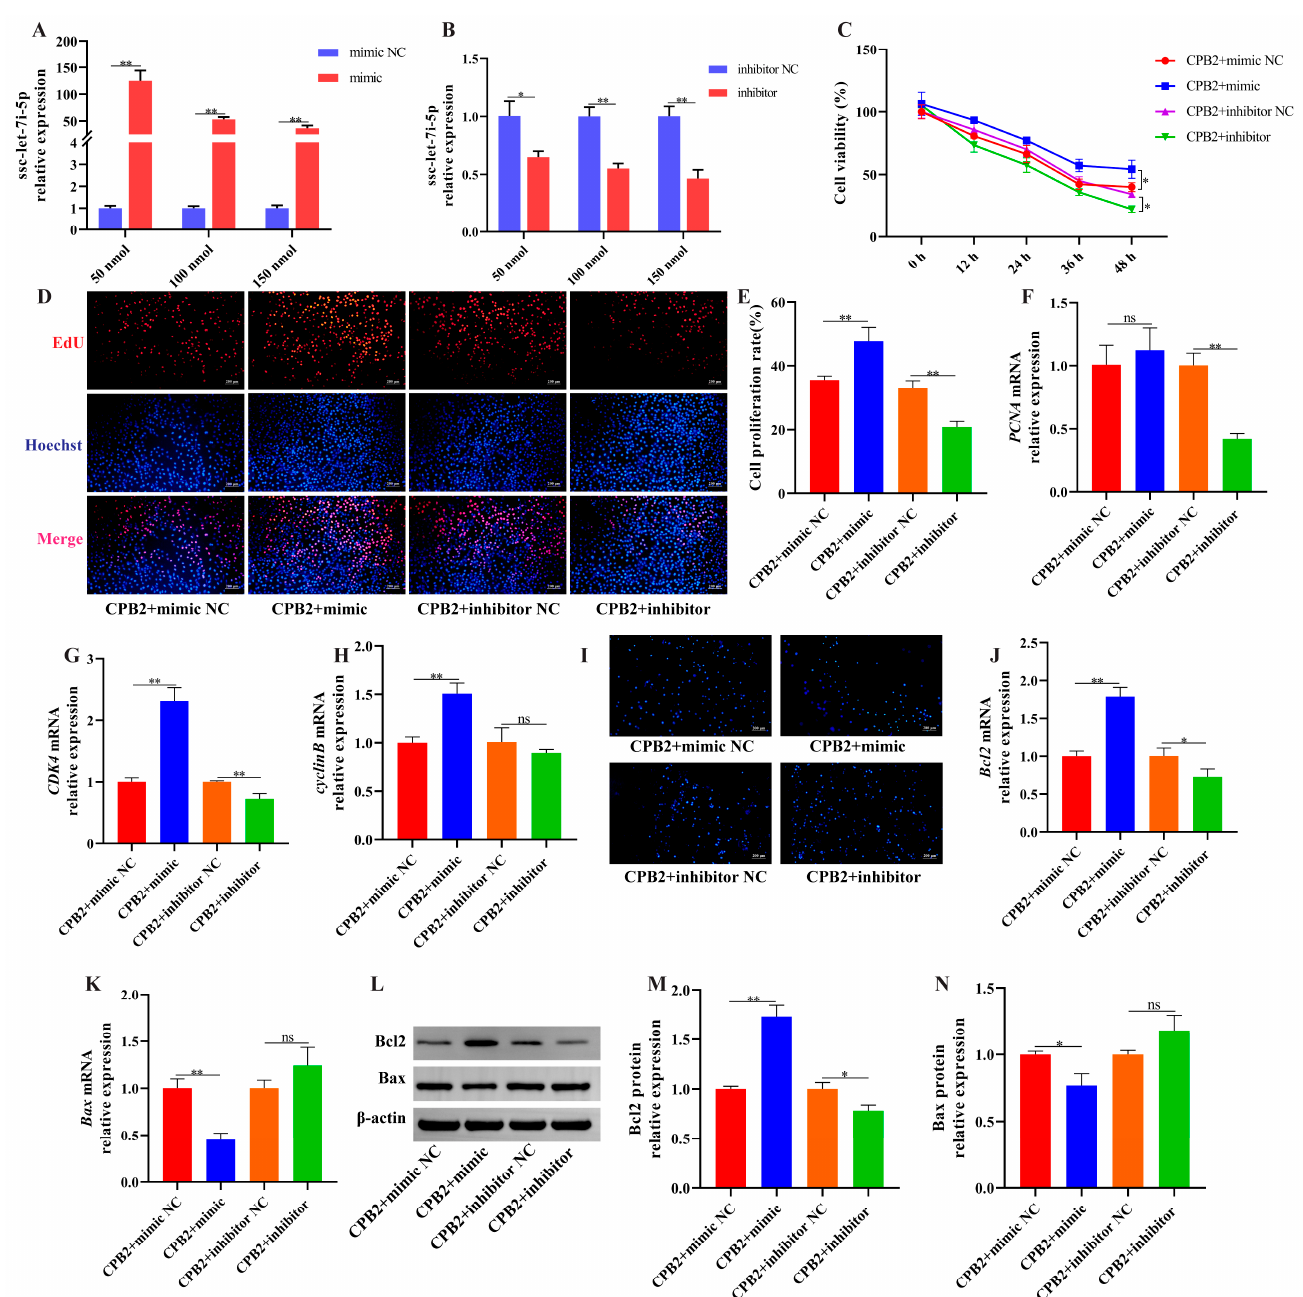
Figure 6. Overexpression of ssc-let-7i-5p alleviated CPB2 toxin-triggered apoptosis in IPEC-J2 cells. ( A ) ssc-let-7i-5p overexpression efficiency via RT-qPCR. ( B ) ssc-let-7i-5p knockdown efficiency via RT-qPCR. ( C ) Cell viability through CCK-8. ( D ) Cell proliferating by EdU staining. ( E ) Percentage of positive proliferating cells. ( F – H ) PCNA , CDK4 and cyclinB levels through RT-qPCR. ( I ) Cell apoptosis by Hoechst 33258 staining. ( J , K ) Bcl2 and Bax mRNA expression via RT-qPCR. ( L – N ) Bcl2 and Bax protein expression through Western blot. ns: not significant. * p < 0.05, ** p < 0.01.